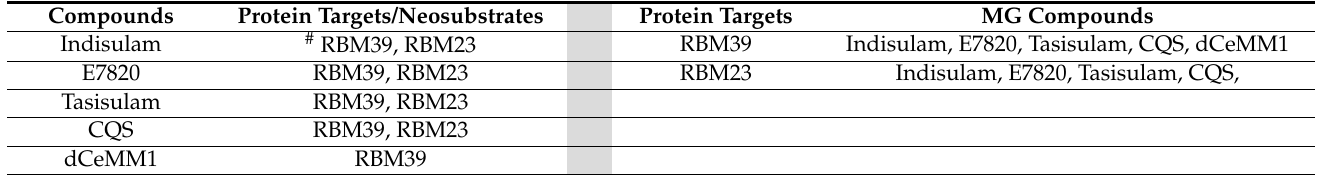
Table 2. Relationship of MGs with their recruited protein substrates using CRL4 DCAF15 *.